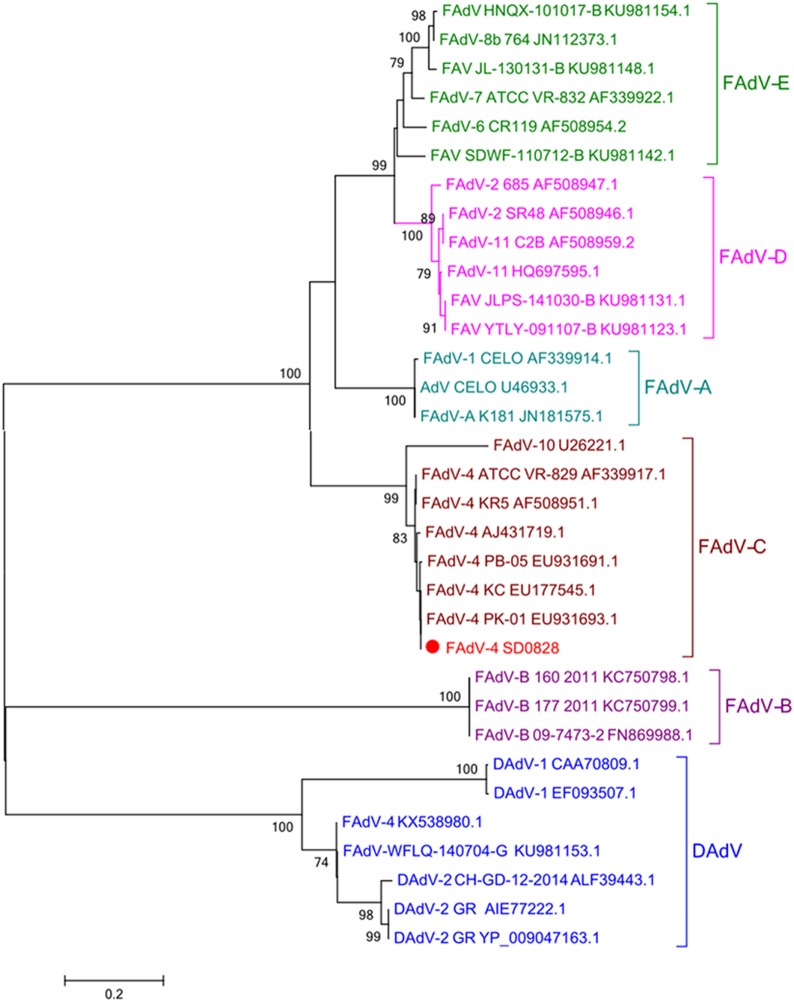
Phylogenetic tree of the isolated FAdV-4 strain (SD0828) based on the L1 loop of hexon gene sequences. Phylogenetic analysis was constructed based on the L1 loop of hexon DNA sequences of the reference strain CELO. The SD0828 sequenced in this study is marked with a solid red circle; other FAdV strains were found on the National Center for Biotechnology website and are referenced to previous studies. GenBank numbers are shown in Table 2. This phylogenetic tree was generated using MEGA 5.1 software employing the neighbor-joining method and a 1,000 bootstrap analysis. The scale bar is 0.2.